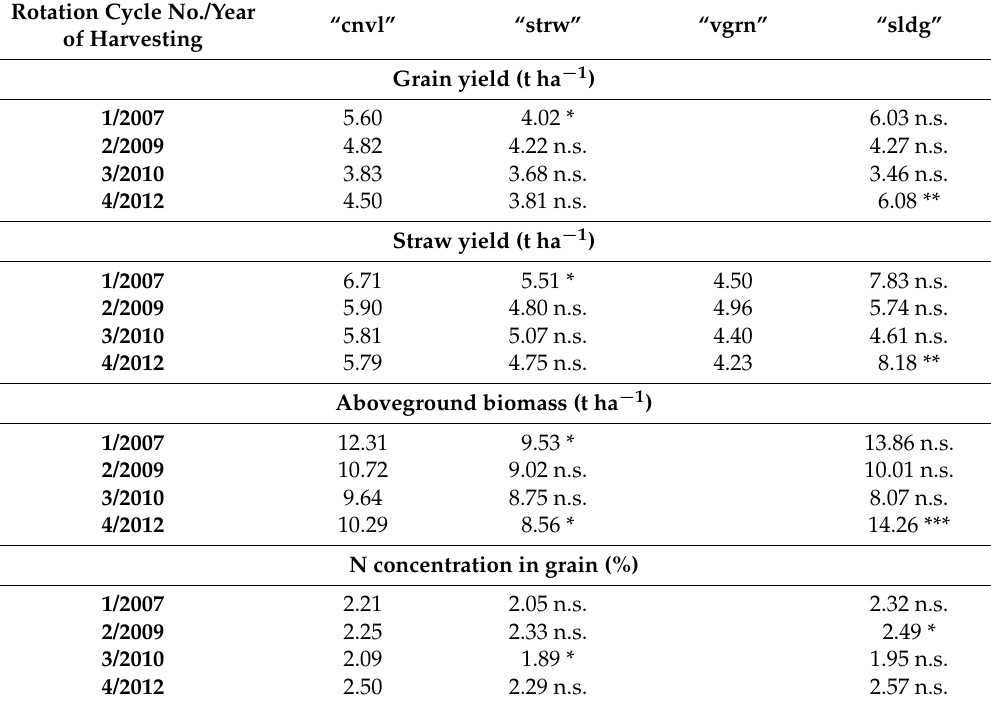
Table 1. Mean wheat yields and N concentration and uptake at the first year of each rotation cycle. Statistical analysis results displayed at the right side of values refer to the comparison between treatments and the “cnvl”. Results in the “vgrn” column refer to vetch. Rotation Cycle